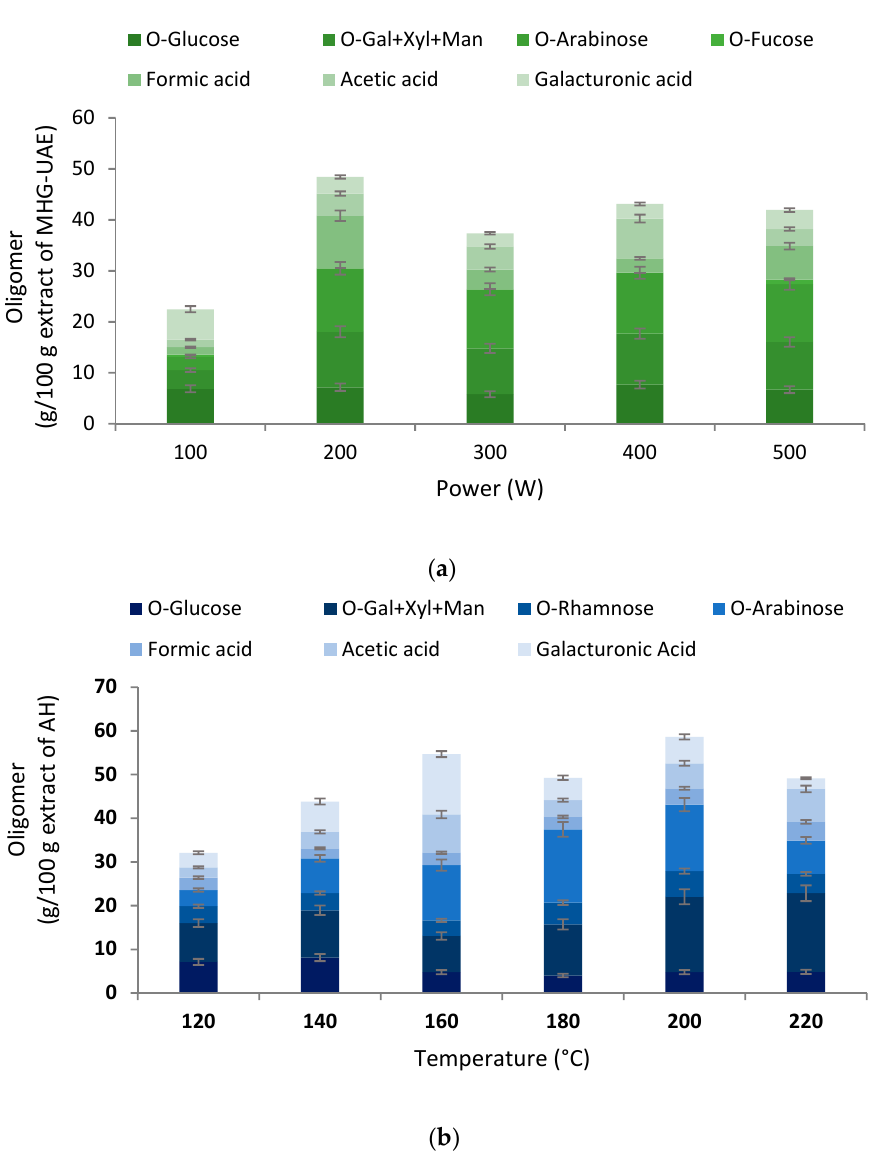
Figure 4. Influence of ( a ) the operation power during MHG on the UAE stage, and ( b ) the final heating temperature during autohydrolysis evaluated on the distribution of components in the oligosaccharide fraction. Data represent n ≥ 3 and standard deviation <5%. Note here that Gal + Xyl + Man corresponds to galactose+xylose+mannose.